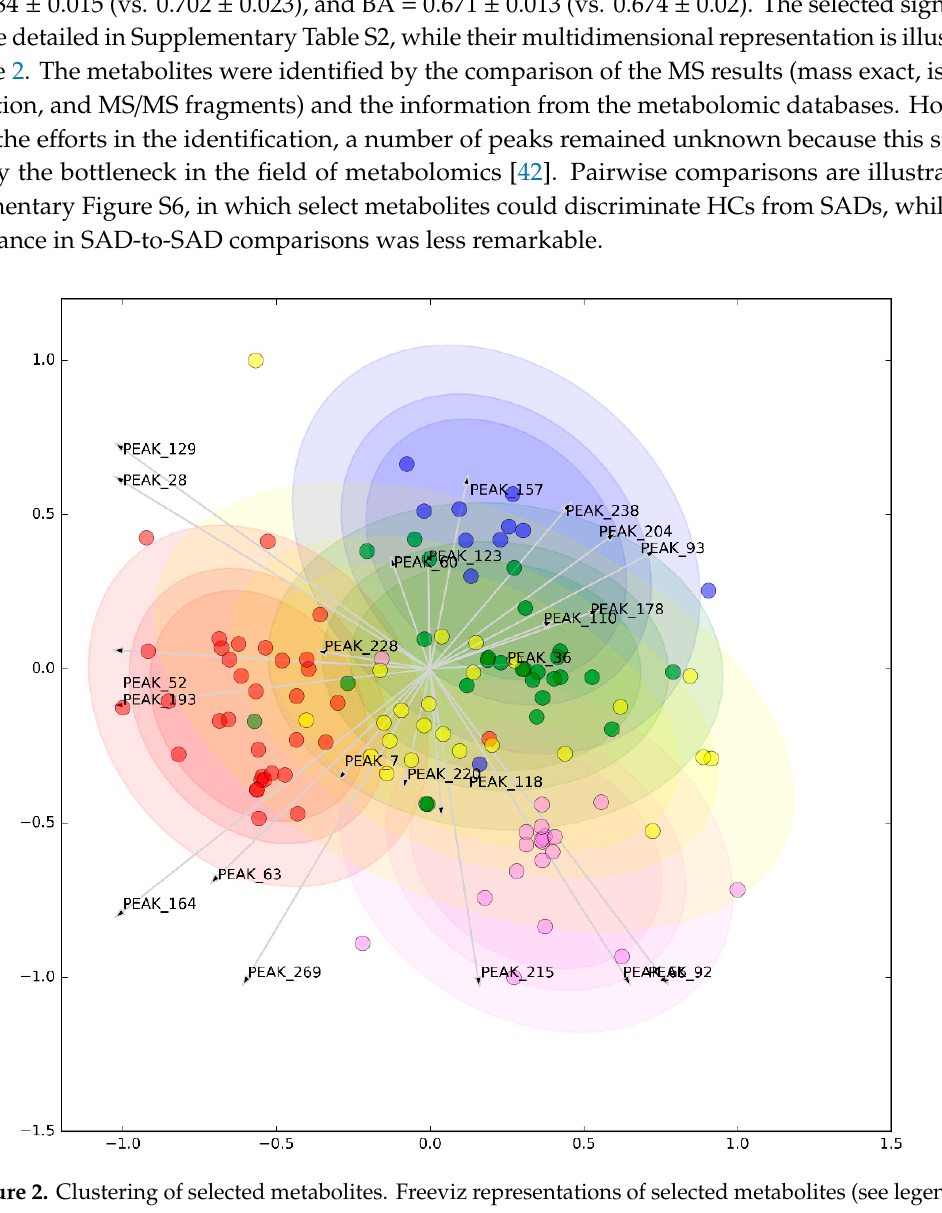
Figure 2. Clustering of selected metabolites. Freeviz representations of selected metabolites (see legend to Figure 1 for